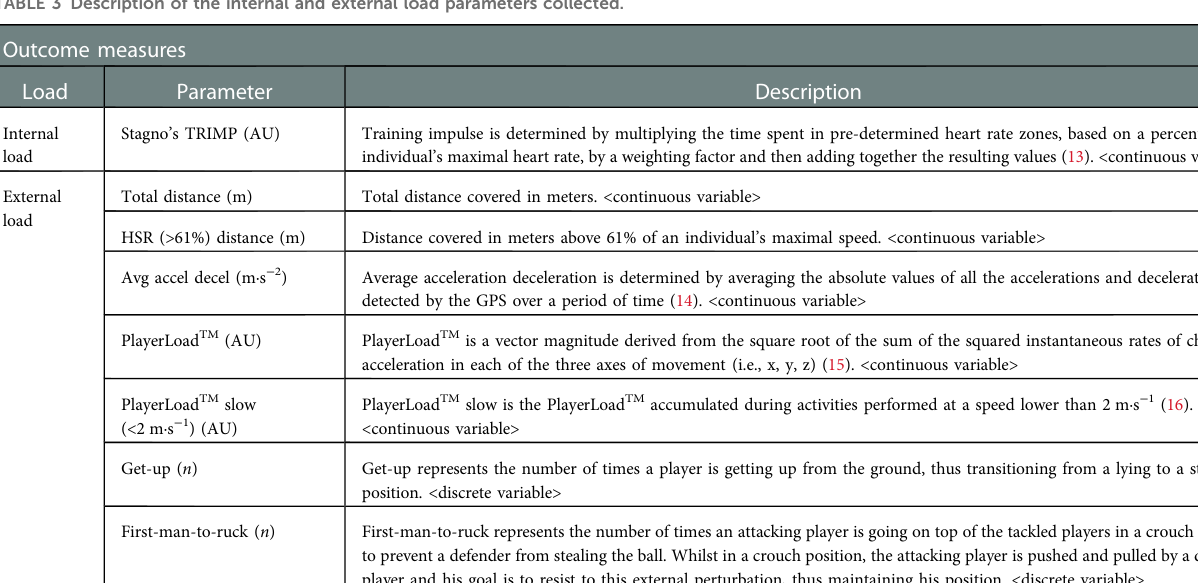
TABLE 3 Description of the internal and external load parameters